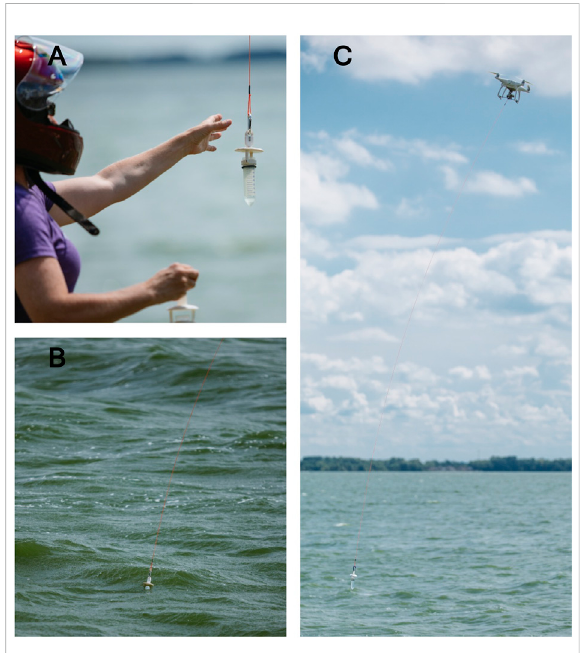
FIGURE 1 The DrOne Water Sampling SystEm (DOWSE) returning a water sample collected in 2019 at GLSM in Celina, OH (A) . The DOWSE collects water samples at the surface (B) , and a